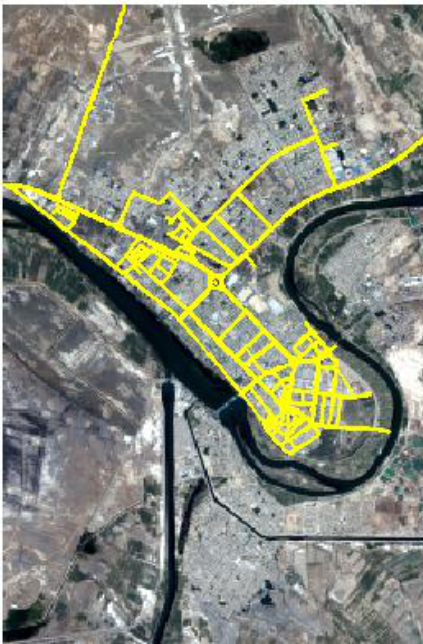
Fig.8: The network of roads from high resolution image at scale